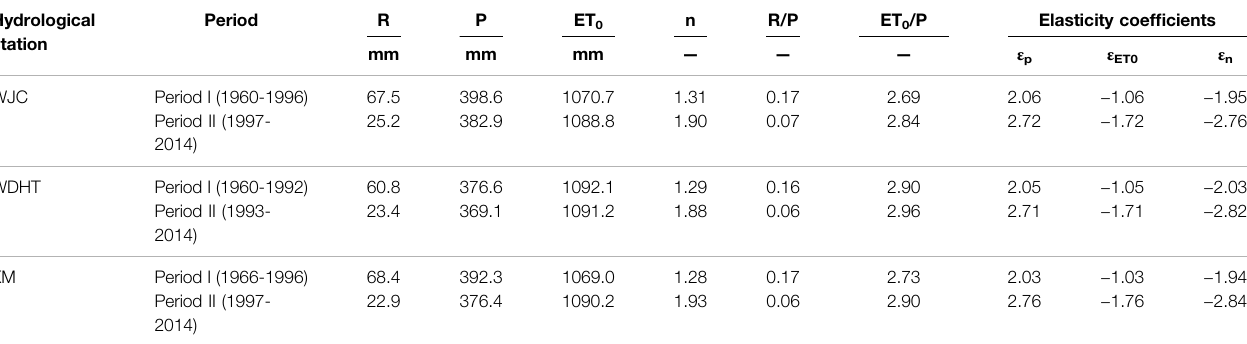
TABLE 2 | Hydrometeorological characteristic values in the Kuye River basin. Hydrological